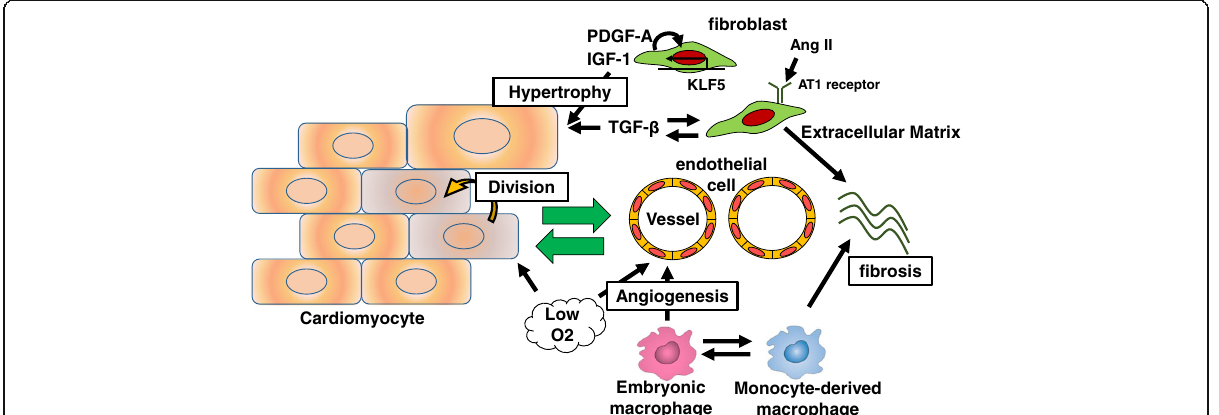
Fig. 1 Interactions among cardiac cells. Most types of cardiac cells, including CMs, cardiac fibroblasts, macrophages, and endothelial cells, regulate cardiac fibrosis and regeneration in a coordinated manner. Some paracrine factors from fibroblasts, including TGF- β and IGF-1, are known to promote the hypertrophic responses of CMs. The regulation of hypoxic environment and macrophage polarization is a key factor for enhancing crucial angiogenic responses involved in cardiac repair and